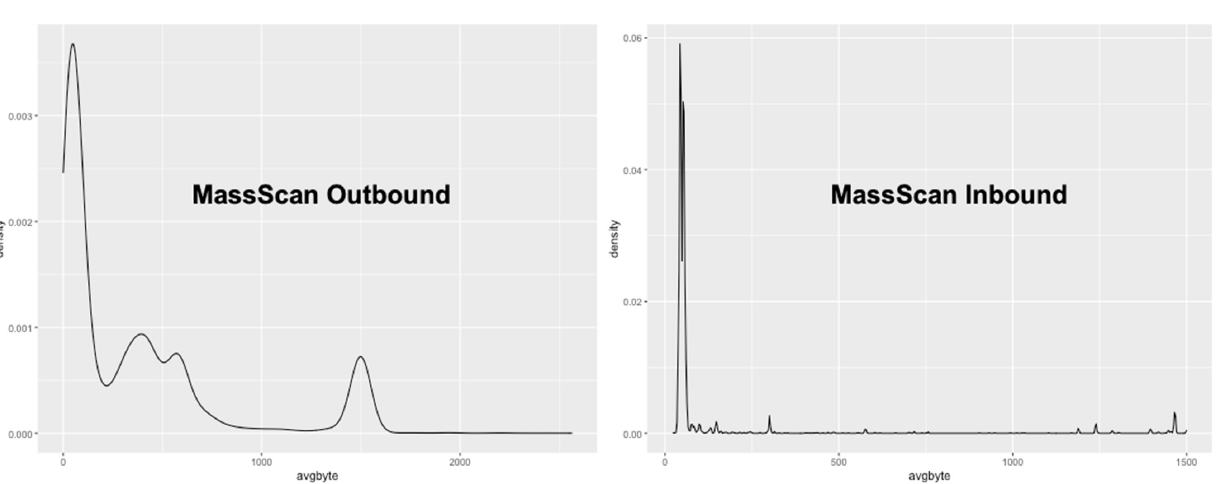
Figure 12. Outbound (left)/inbound (right) of average bytes from 7 victim IPs.